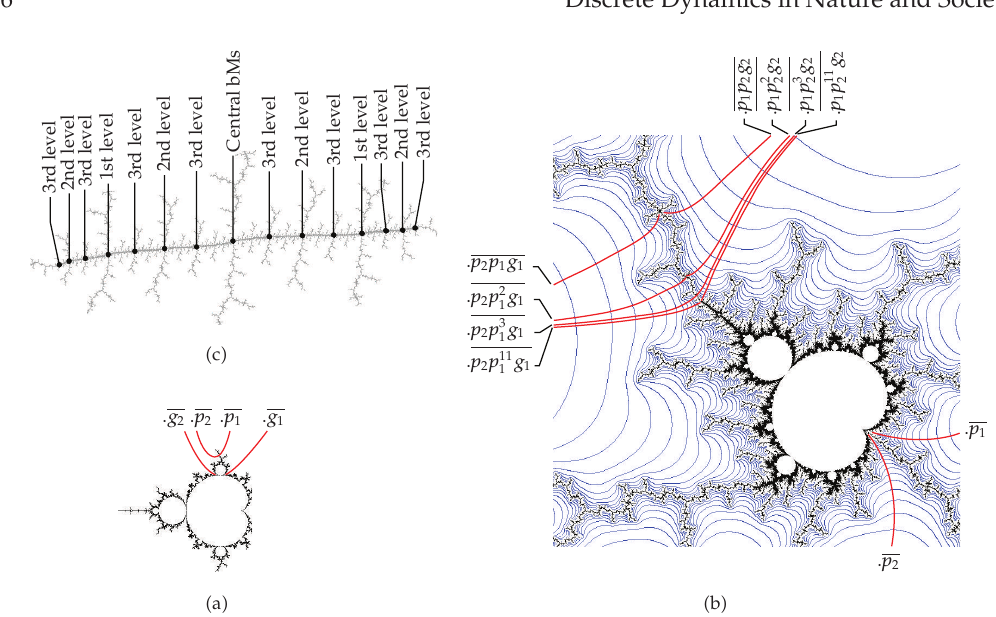
Figure 3: Canonical nonspiral medallions. (cid:4) a (cid:5) External rays of the parent and the gene. (cid:4) b (cid:5) Graphical location of the medallions i (cid:3) 1 , 2 , 3 and 11. (cid:4) c (cid:5) Detail of the medallion i (cid:3) 11, where the BMSs up to third level are pointed